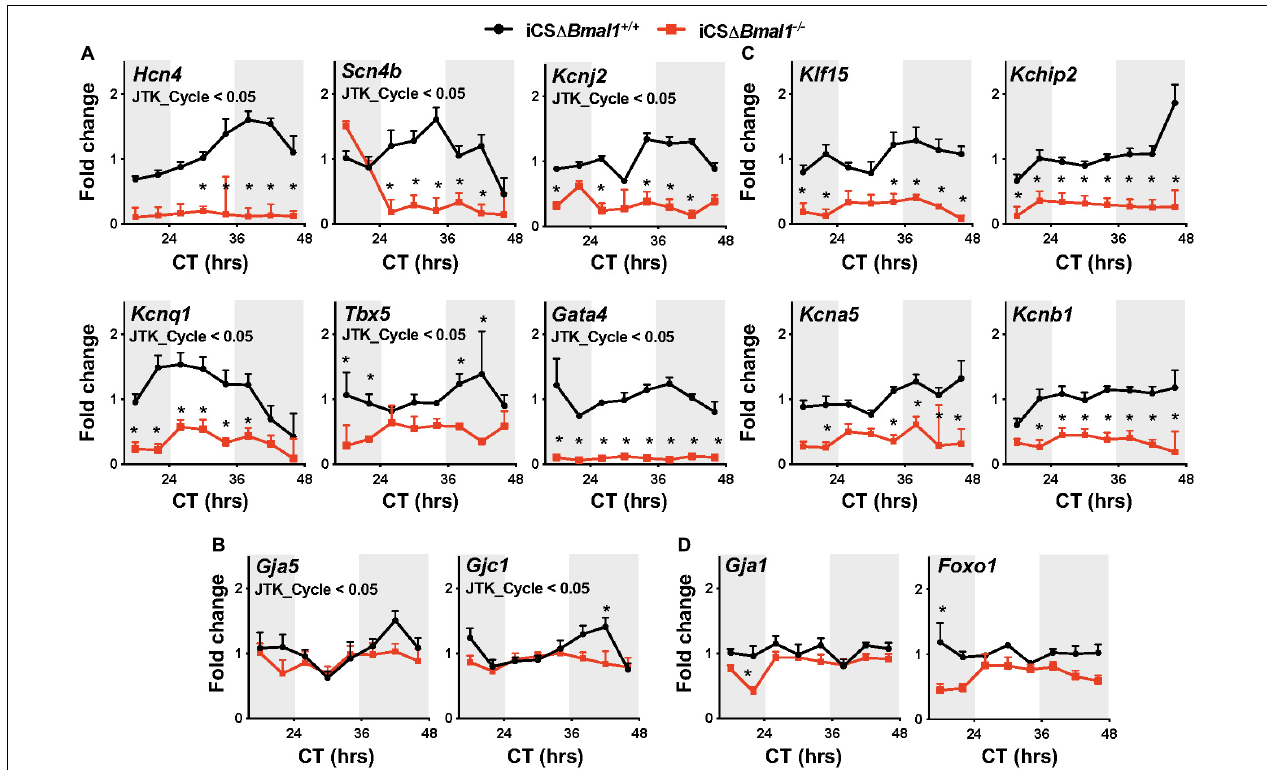
FIGURE 1 | Inducing the deletion of Bmal1 in adult cardiomyocytes differentially impacts the temporal expression of cardiac ion channel transcripts. Shown are qPCR profiles for mRNA transcripts measured from iCS (cid:49) Bmal1 + / + (black circles) and iCS (cid:49) Bmal1 − / − (red squares) mouse hearts plotted as a function of circadian time (CT). Light and shaded regions on x-axis represent subjective light and dark cycles. (A) Hcn4 , Scn4b, Kcnj2 , Kcnq1 , Tbx5 , and Gata4 mRNA transcripts had circadian expression profiles in the hearts of iCS (cid:49) Bmal1 + / + mice (JTK_Cycle < 0.05) but not iCS (cid:49) Bmal1 − / − mice. mRNA expression was lower at most time points in the hearts of iCS (cid:49) Bmal1 − / − mice when compared to iCS (cid:49) Bmal1 + / + mouse hearts ( n = 3–4/time point; * p < 0.05). (B) Gja5 and Gjc1 mRNA transcripts had circadian expression profiles in iCS (cid:49) Bmal1 + / + mouse hearts (JTK_Cycle < 0.05) but not iCS (cid:49) Bmal1 − / − mouse hearts. The overall transcript levels were similar in iCS (cid:49) Bmal1 + / + and iCS (cid:49) Bmal1 − / − mice at most circadian time points ( n = 3-4/time point; * p < 0.05). (C) Klf15 , Kchip2 , Kcna5 , and Kcnb1 mRNA transcripts did not have circadian expression profiles in the hearts of iCS (cid:49) Bmal1 + / + or iCS (cid:49) Bmal1 − / − mice. (JTK_Cycle > 0.05). The overall transcript levels were lower in iCS (cid:49) Bmal1 − / − mouse hearts compared to transcript levels in iCS (cid:49) Bmal1 + / + mouse hearts at most circadian time points ( n = 3–4/time point; * p < 0.05). (D) Gja1 and Foxo1 mRNA transcripts did not have circadian expression profiles in the hearts of iCS (cid:49) Bmal1 + / + or iCS (cid:49) Bmal1 − / − mice (JTK_Cycle > 0.05) and the